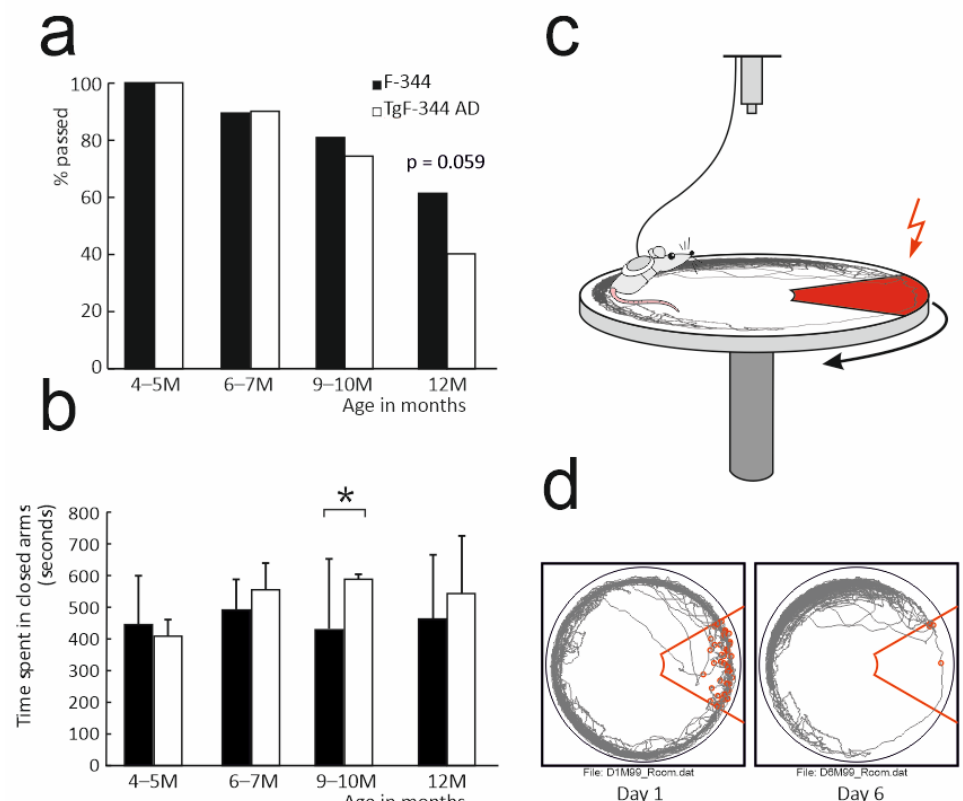
Figure 1. ( a ) Proportion of animals passing the visible platform Water Maze test (in percentage). ( b ) Time spent in the closed arms of the Elevated Plus Maze (median/interquartile range). The significant between-group comparison is marked with an asterisk. ( c ) Schematic drawing of the AAPA apparatus. The red area indicates the zone where the footshock was delivered upon entry (not marked in real situation). The arrow shows the direction of the arena rotation. ( d ) Examples of cumulative tracks (grey line) in the room coordinates frame from sessions on the first (left) and on the last day (right) of the training of one animal. The red lines show the contours of the zone with the footshock. The red circles indicate places where the footshocks were delivered.